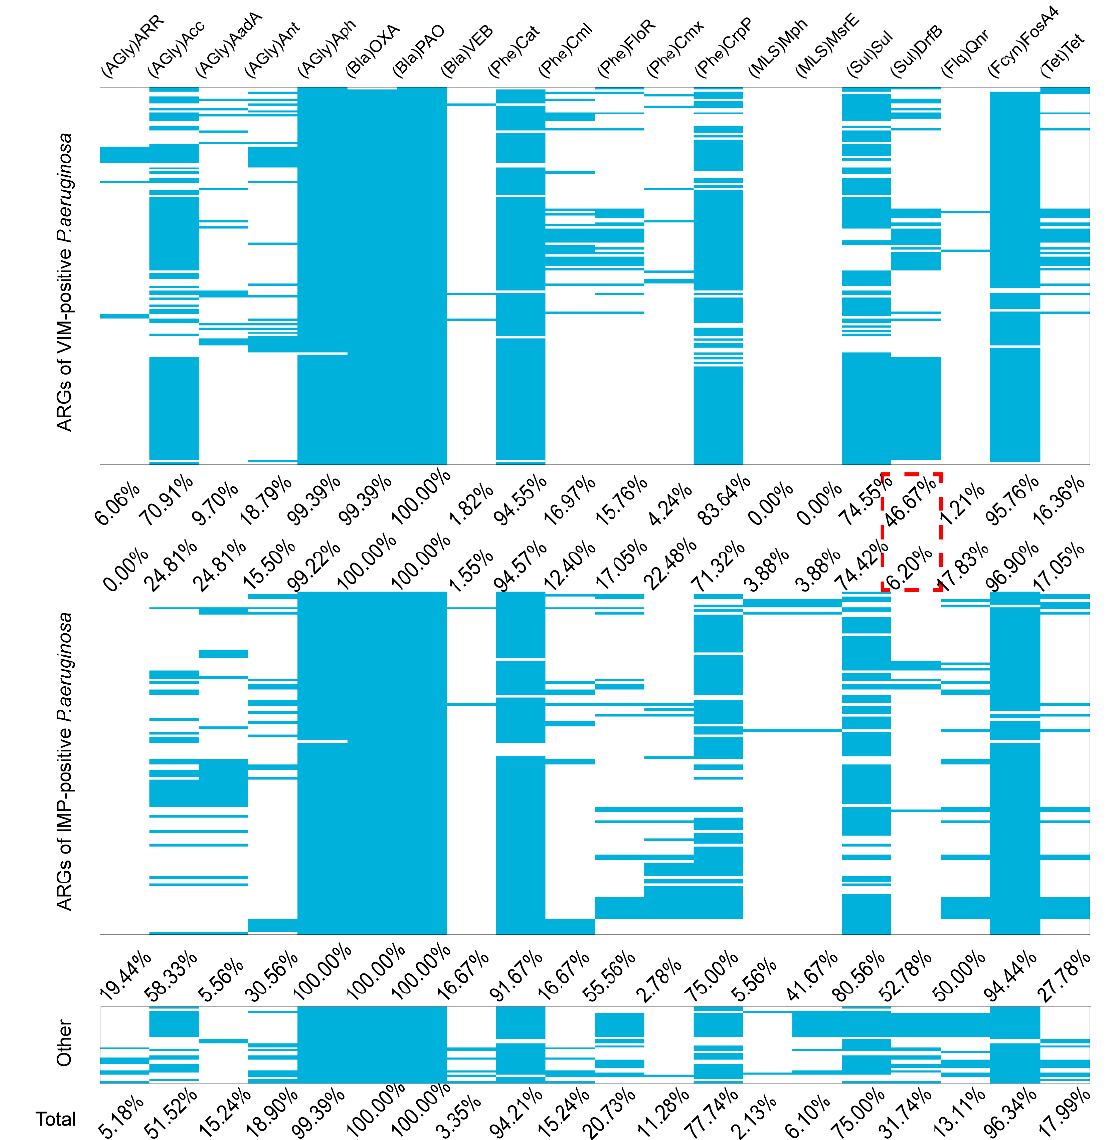
Figure A2. ARGs present among the bla VIM- and bla IMP -positive P. aeruginosa isolates found in this study. The blue represents positive for ARGs in the bla VIM- and bla IMP -positive P. aeruginosa isolates. The red dotted line represents a special value of worth noting